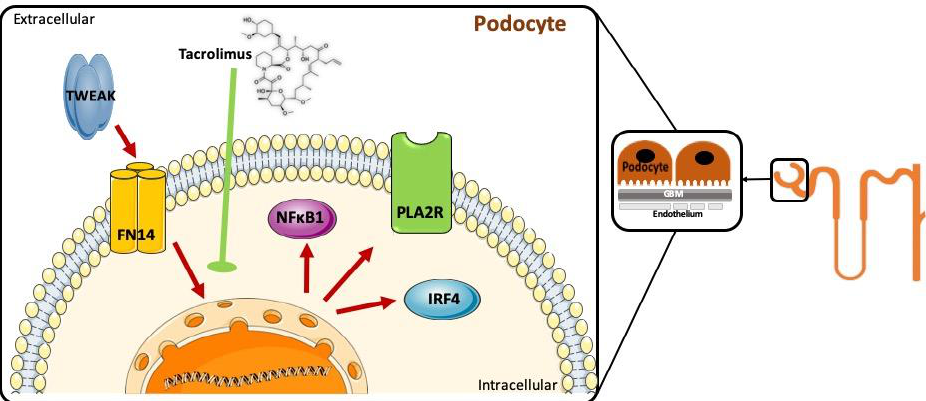
Figure 5. TWEAK activation of Fn14 results in increased podocyte expression of non-human leukocyte antigen (HLA) genes associated by GWAS to human membranous nephropathy. Fn14 is the receptor for the inflammatory cytokine TWEAK. The activity of the TWEAK/Fn14 axis is usually regulated by receptor availability, although TWEAK levels may also increase in the course of inflammation. After identifying upregulation of TNFRSF12A , the gene encoding Fn14, and of PLA2R1 in human membranous nephropathy, we have shown that TWEAK increases PLA2R expression in human podocytes, thus potentially contributing to increased antigen availability and the generation of local immune complexes. Tacrolimus decreased the TWEAK-induced expression of PLA2R and other genes associated to membranous nephropathy by GWAS. This may contribute to its therapeutic impact in the clinic.